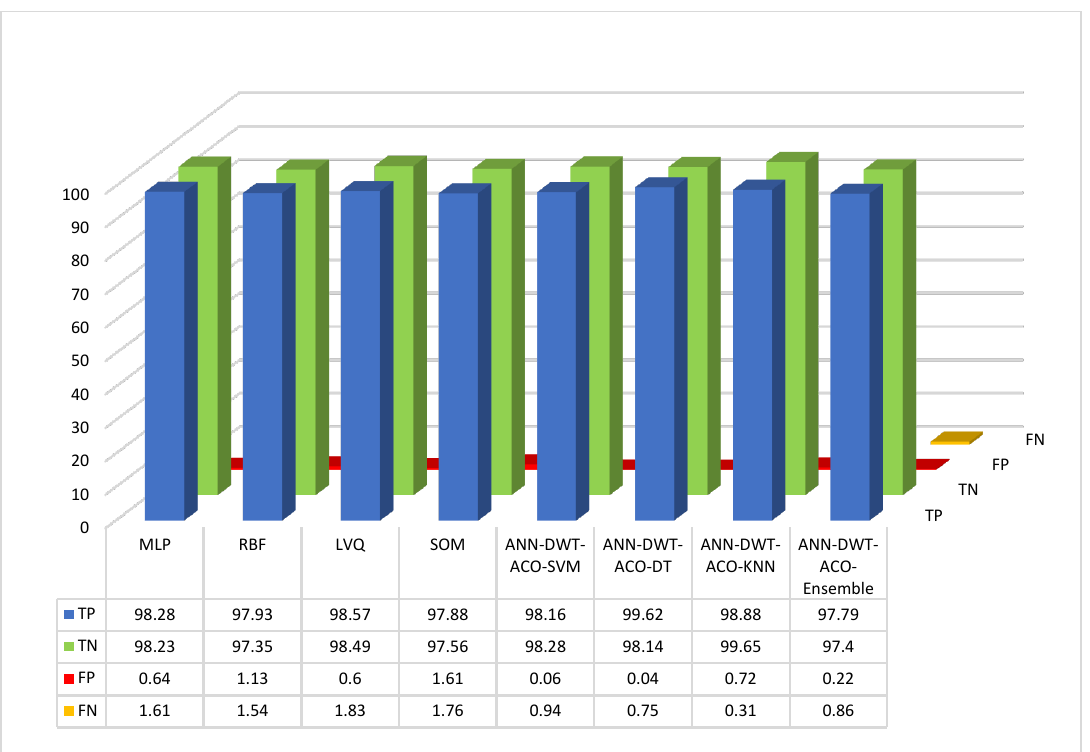
Figure 11. Graphical illustration of the TP, TN, FP, and FN.